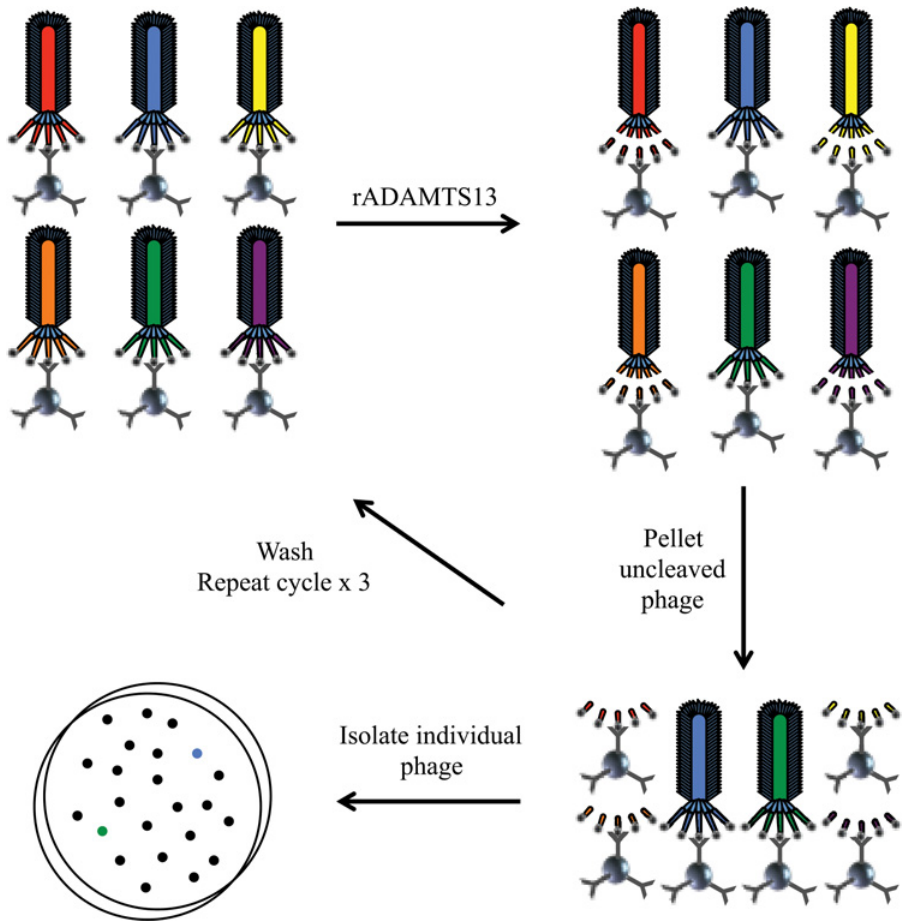
Fig 1. Phage screen process. Freshly prepared library phage where incubated with rADAMTS13 in cleavage buffer in the presence of anti-FLAG antibody coated beads. Uncleaved phage were separated from cleaved phage by centrifugation and washed. Phage on beads were exposed to three additional rounds of incubation with rADAMTS13. Individual phage were isolated by direct infection to K91 cells and plating on tetracycline containing NZY